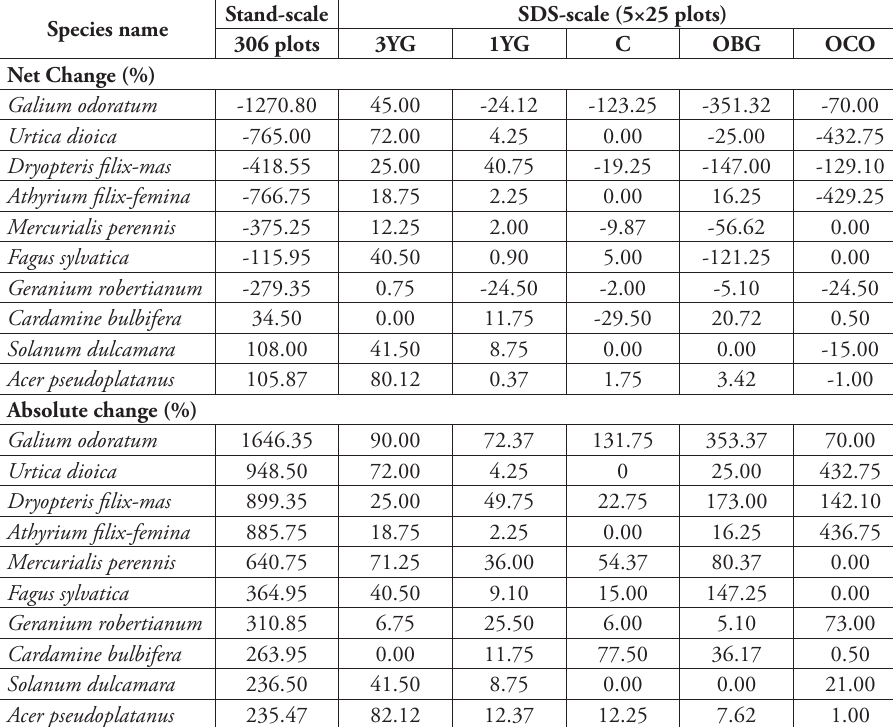
Table 4. Net and absolute cover change (%) of the ten most responsive species between 1996 and